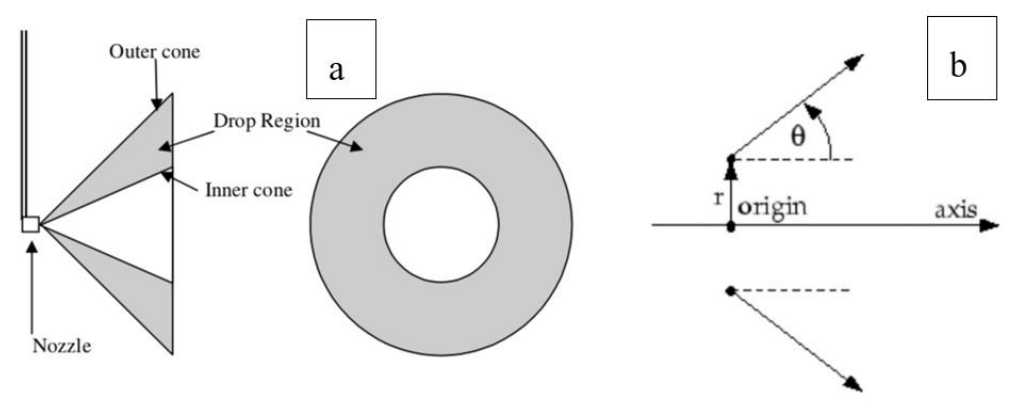
Figure 5. ( a ) The structure of the hollow cone spray nozzle used in the experiment of [24]; ( b ) Hollow cone half-angle = θ as defined in ANSYS Fluent 18.1.